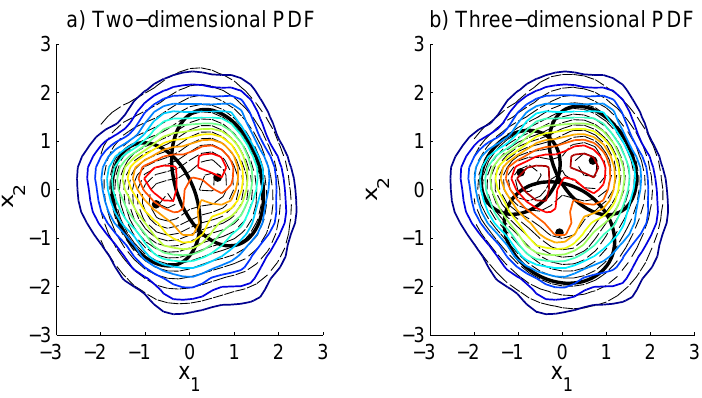
Fig. 10. Kernel PDF estimate of the leading two Isomap time series along with the two- (a) and three- (b) component gaussian mixture model. The mixture PDF is shown by the dashed lines. The covariance ellipses of each component along with the respective centres (black dots) are also shown.